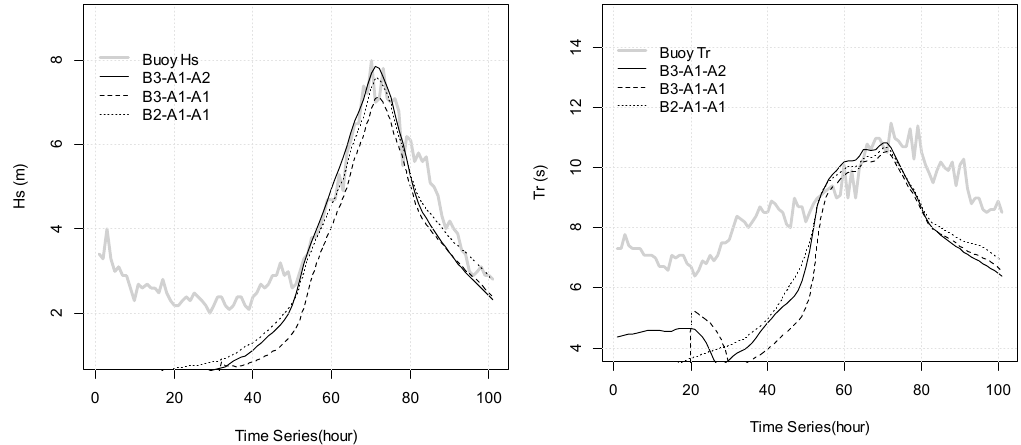
Figure A3. Comparison of typhoon waves induced by Typhoon Nesat (17-2011) at buoy QF302: the standard H10 is indexed as B2-A1-A1, the model with varying parameter b without an asymmetric typhoon structure is indexed as B3-A1-A1, and MH10 is indexed as B3-A1-A2.